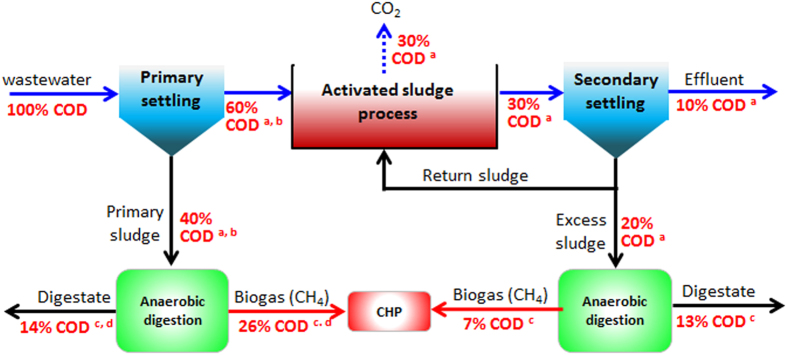
COD mass flow through a conventional domestic wastewater treatment plant.(a) data from Metcalf and Eddy12; (b) data from Rossle and Pretorius18; (c) data from Parkin and Owen47; (d) data from Miron et al.48.